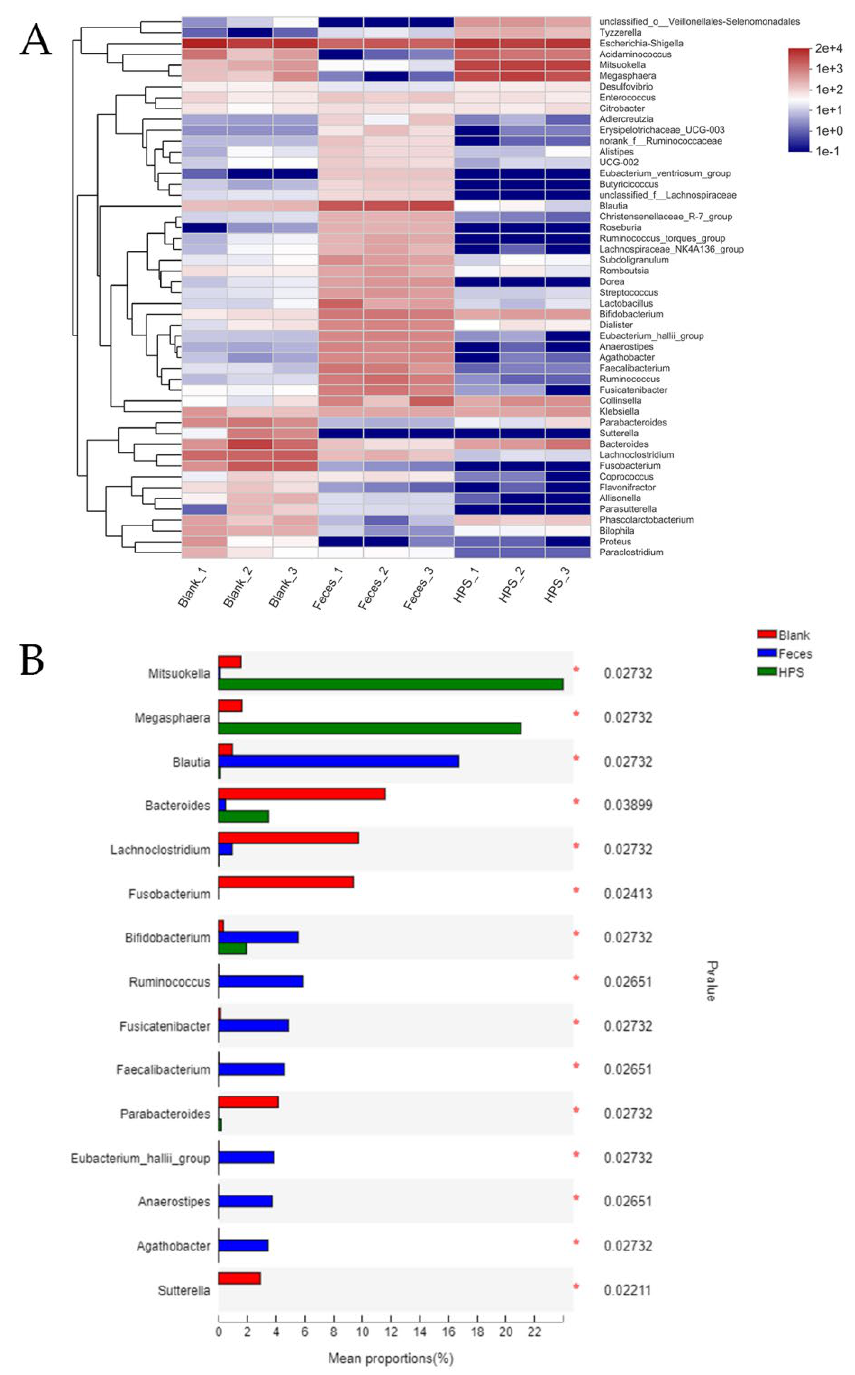
Figure 6. Heatmap of analysis at the genus level for different groups ( A ); the species differences were compared among the groups at the genus level ( B ).